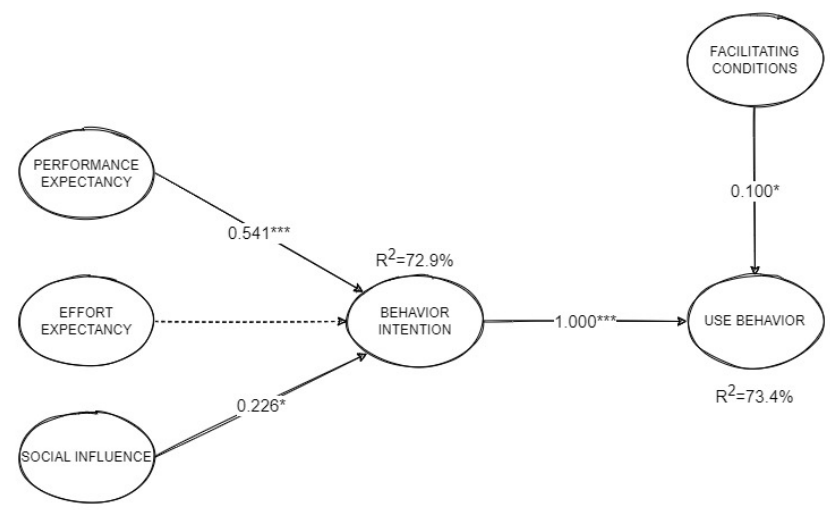
Figure 3. Final model with R variance and total effect. Note: * p < 0.05, *** p < 0.001